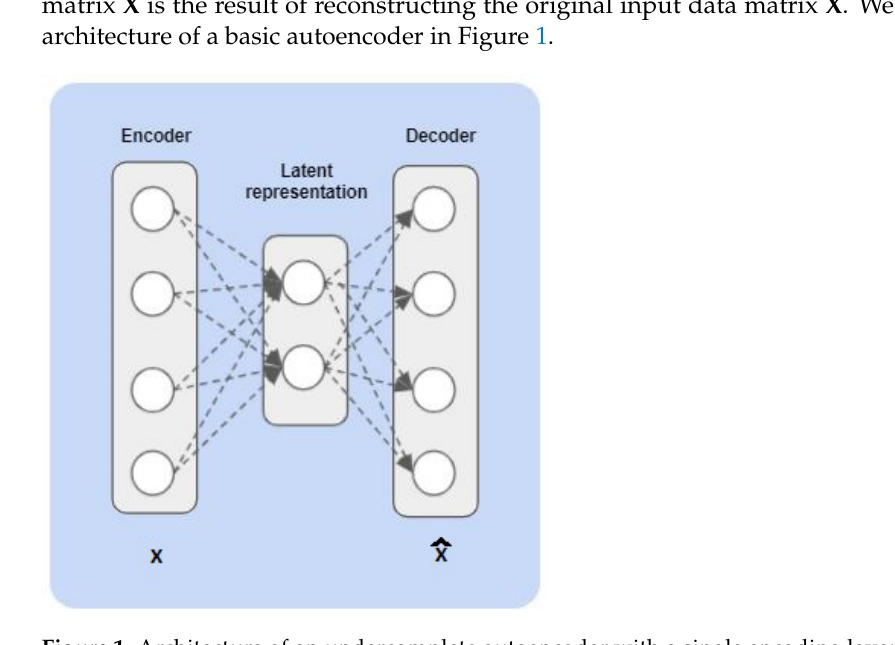
Figure 1. Architecture of an undercomplete autoencoder with a single encoding layer and a single decoding